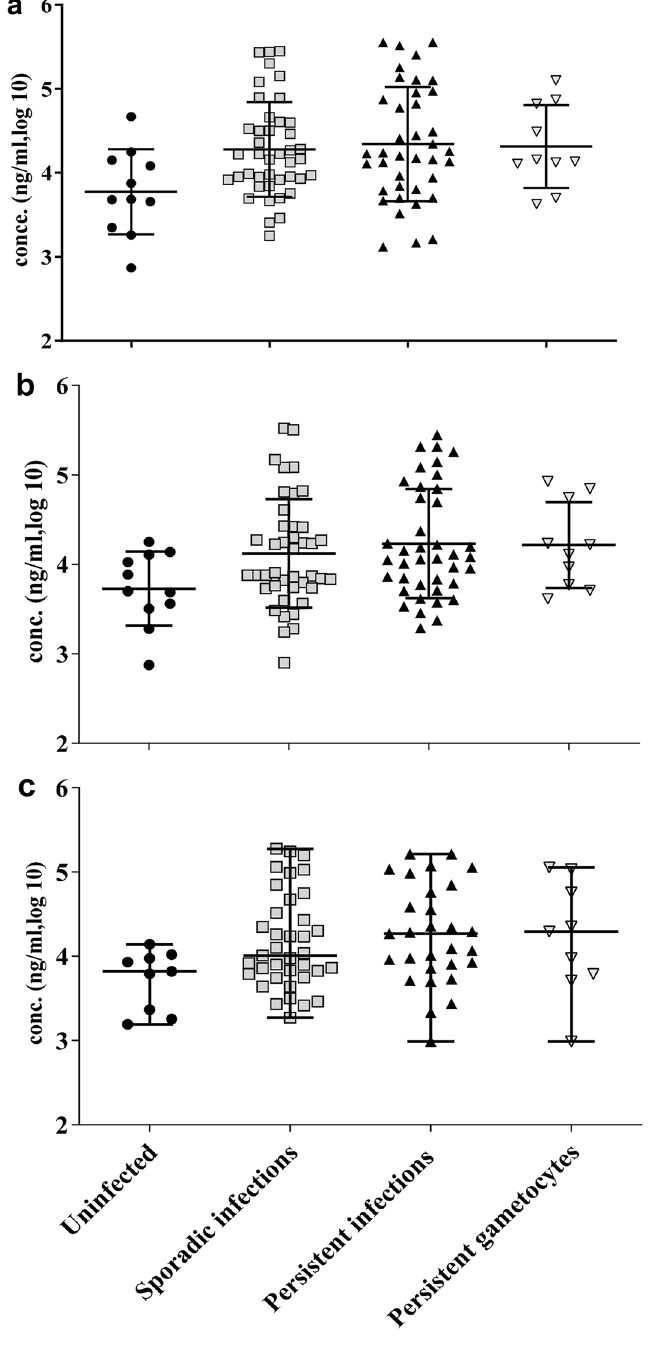
Figure 4. Antibodies against the asexual antigen EBA175 RIII–V over the course of the study. Anti- EBA175RIII–V IgG antibody concentrations (ng/ml, log 10) were measured monthly [days 14 ( a ), 42 ( b ), and 70 ( c )] in plasma from all the participants. The antibody concentrations obtained at each time point are plotted in groups based on overall infectivity status. Uninfected (n = 11), sporadically infected, ≤ 4 infections (n = 49), persistently infected ≥ 5 infections (n = 39), and persistent gametocytes, ≥ 5 episodes (n = 11) were assessed using P. falciparum Pf18S rRNA and Pfs25 transcripts for the detection of total parasite and gametocyte infections respectively. The median and interquartile range is shown and one-way ANOVA did not detect differences between the groups. The p values (p = 0.1647–0.7274) are listed in Supplementary Table